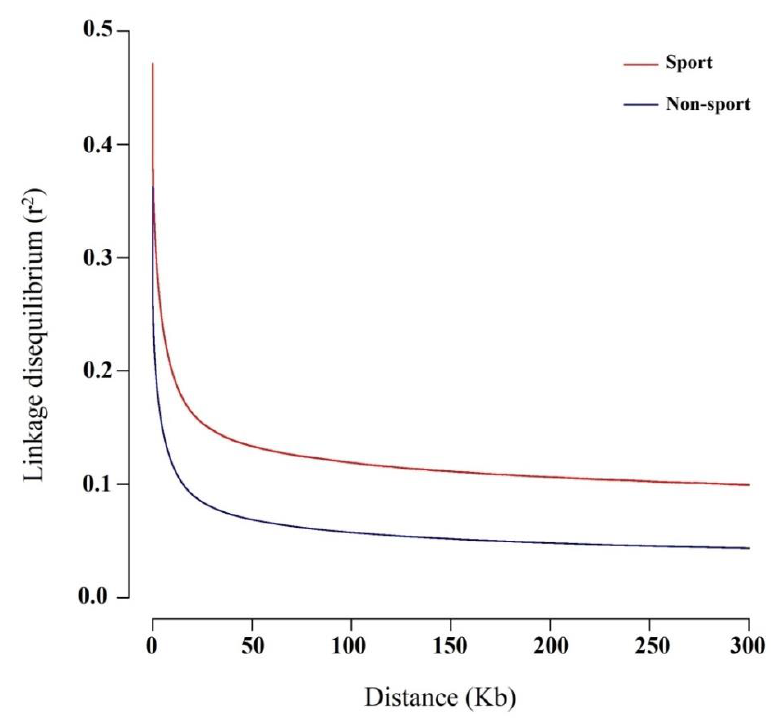
Figure 4. Linkage disequilibrium decay among sport (red) and non-sport (blue) groups.